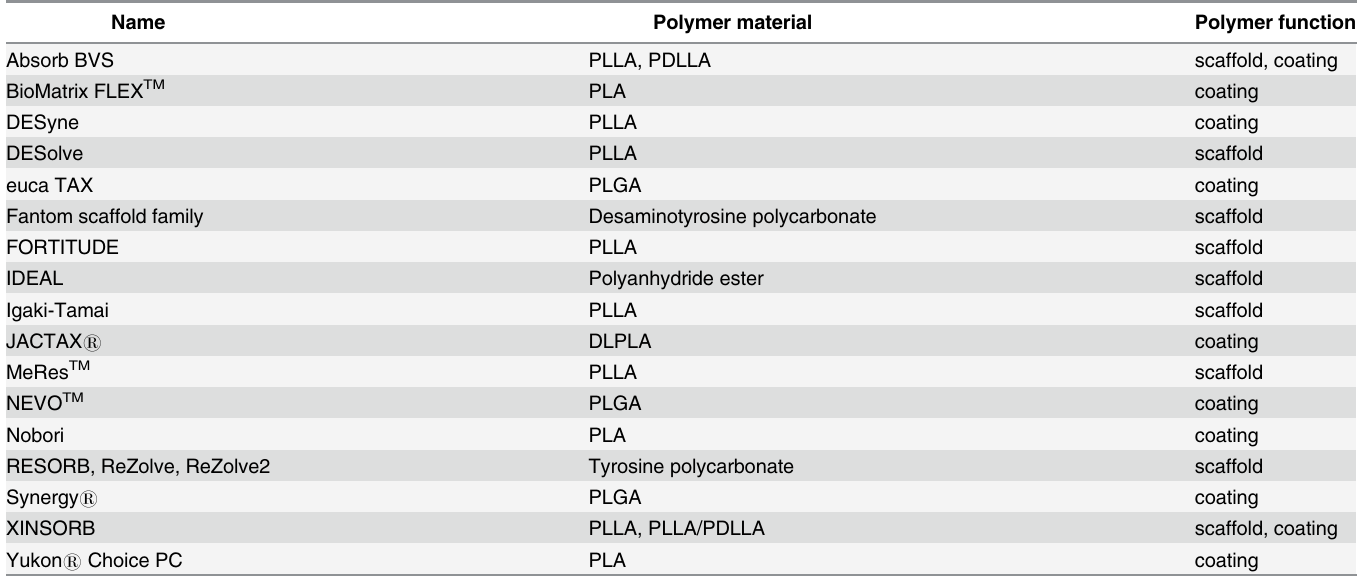
Table 1. Biodegradable polymers in stent